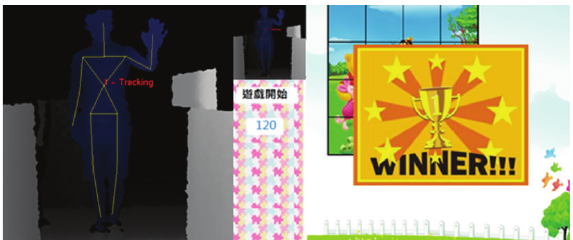
Figure 15: The completeness of puzzle game.